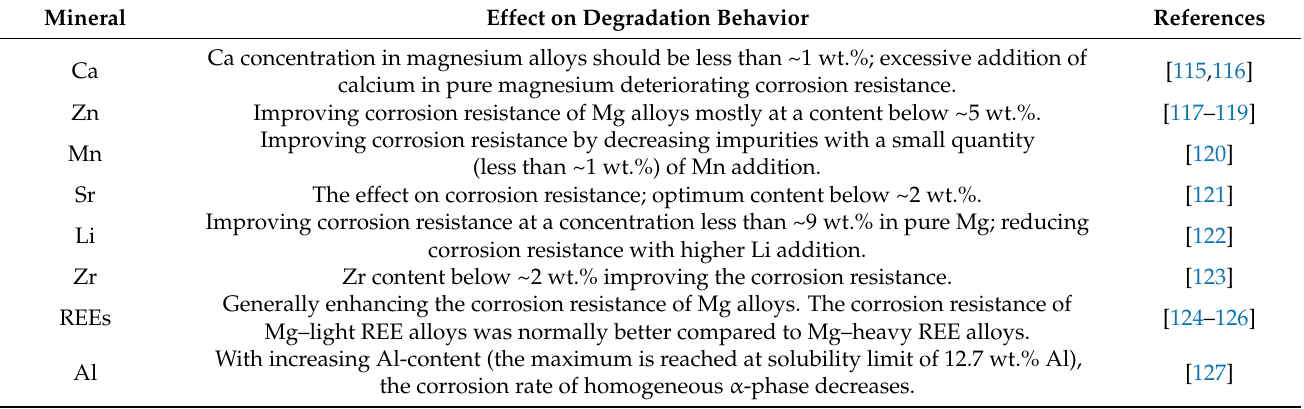
Table 1. Summary of the effect of most common alloying elements on the degradation behavior of Mg alloys. Effect on Degradation